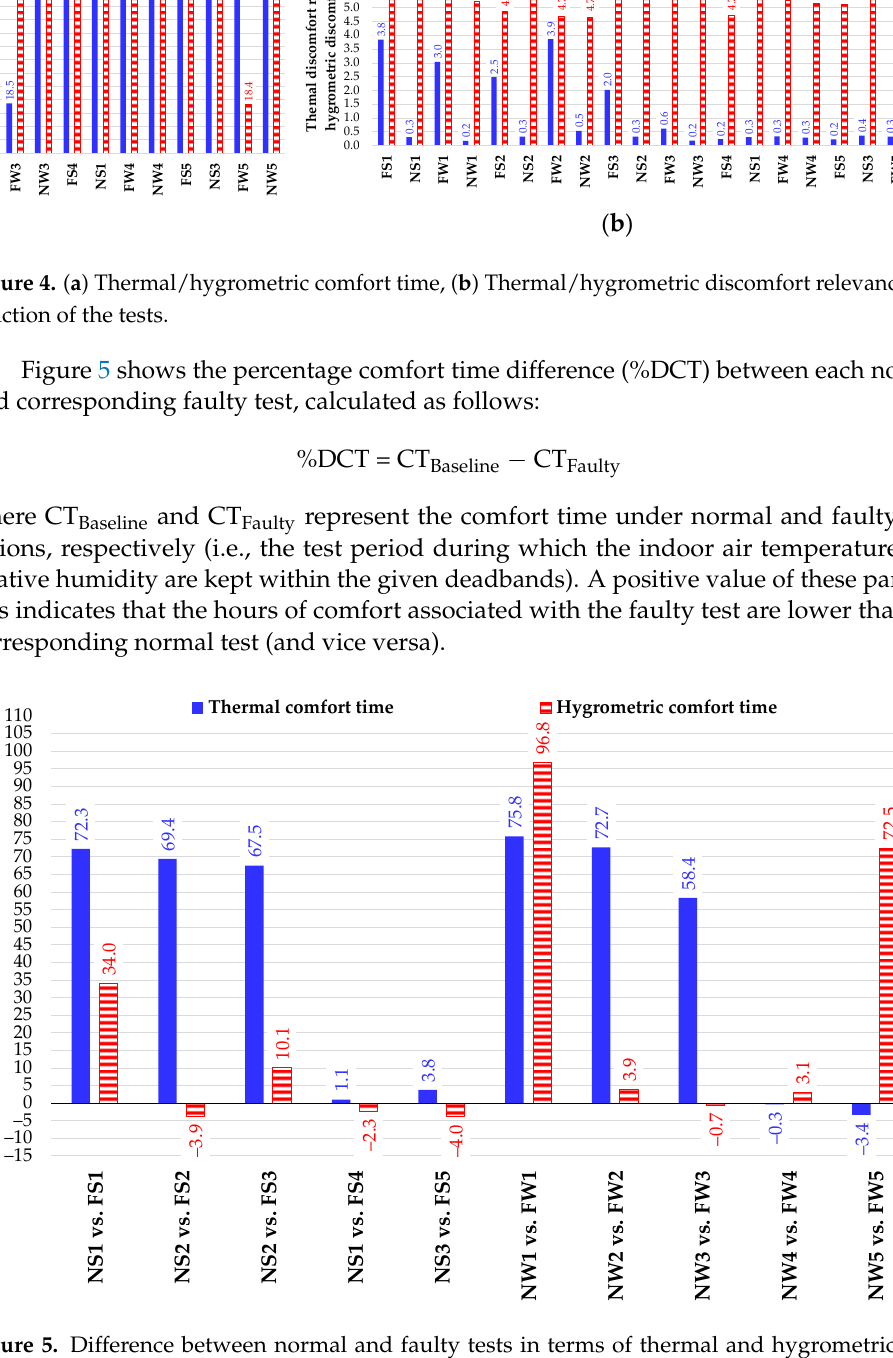
Figure 5. Difference between normal and faulty tests in terms of thermal and hygrometric com- fort